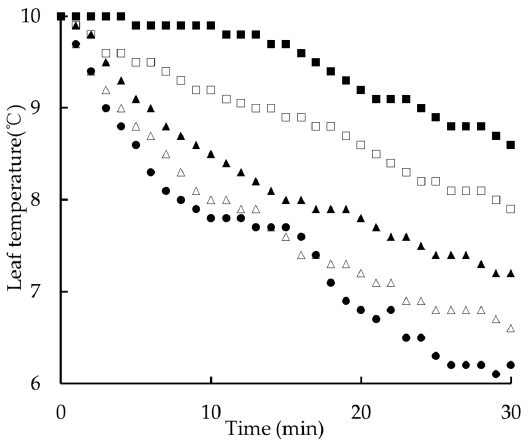
Figure 10. T l when the T radiation was set to 0 °C ( ■ ), − 10 °C ( □ ), − 20 °C ( ▲ ), − 30 °C ( △ ), and − 40 °C ( ● ). When T radiation was set to 0, 10.0, 20.0, 30.0, and 40.0 °C, T l decreased 1.4, 2.1, 2.8, 3.4, and 3.8 °C,